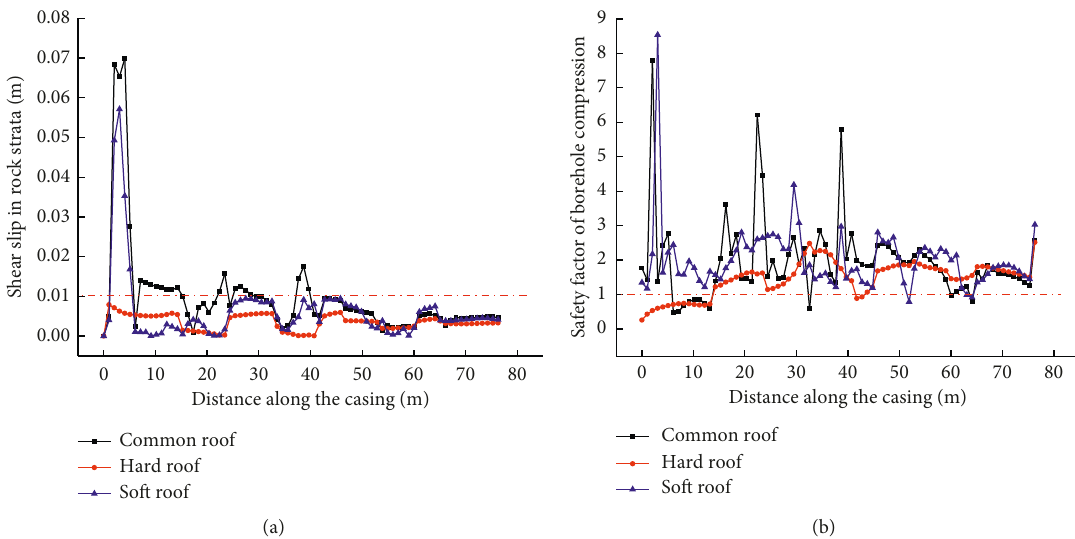
Figure 13: Effect of roof lithology on the stability of the borehole. (a) Effect of roof lithology on the shear stability of the borehole. (b) Effect of roof lithology on the compressional stability of the